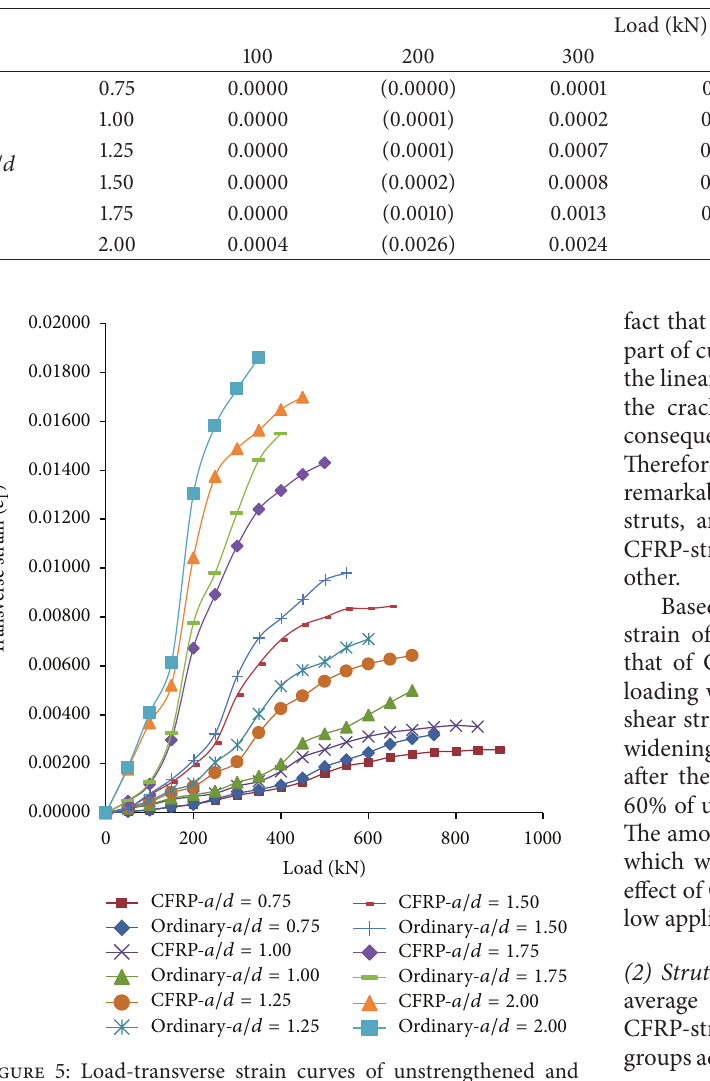
Table 3: Difference of transverse tensile strains of the unstrengthened and CFRP-strengthened RC struts.